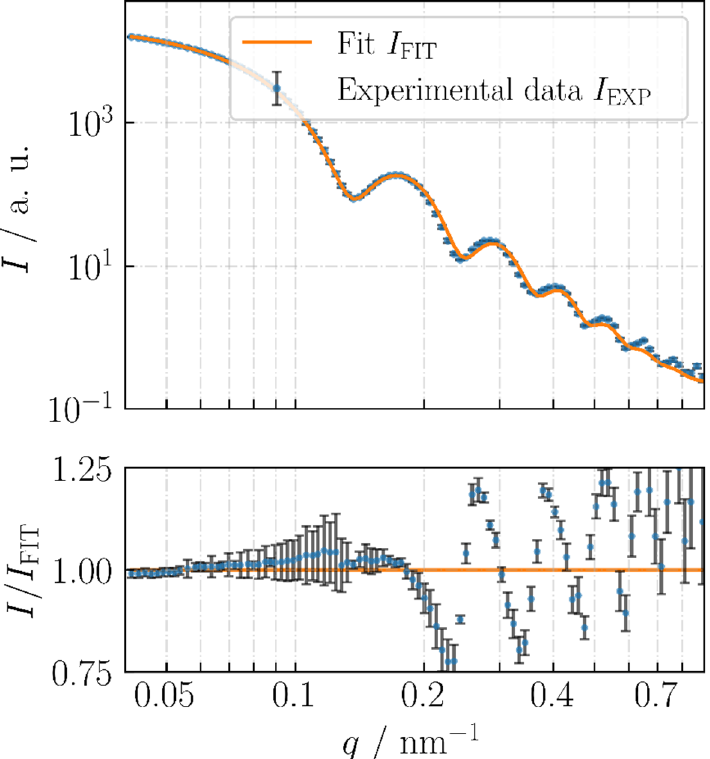
Figure 11. Experimental SAXS curve (symbols) of the nPSize04 (nanocubes) material together with the fit for cubes with rounded edges (solid orange line).